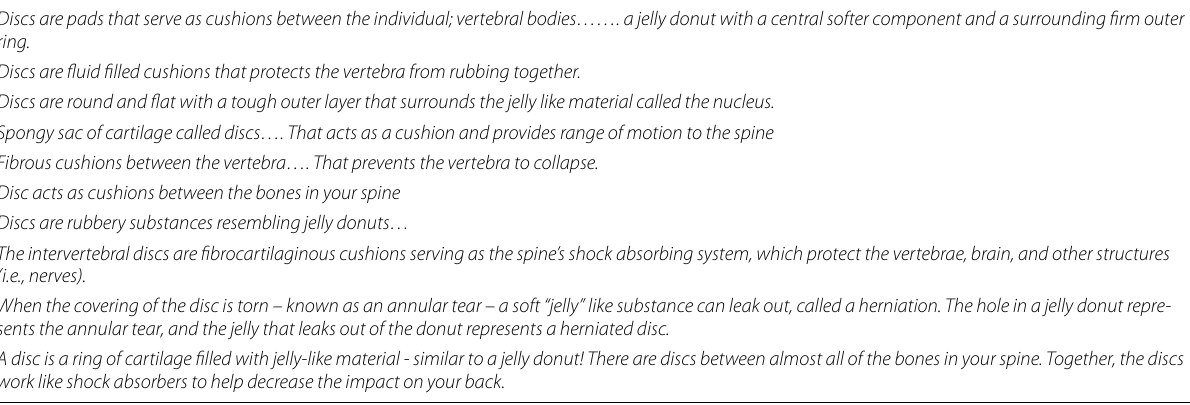
When the covering of the disc is torn – known as an annular tear – a soft “jelly” like substance can leak out, called a herniation. The hole in a jelly donut repre- sents the annular tear, and the jelly that leaks out of the donut represents a herniated